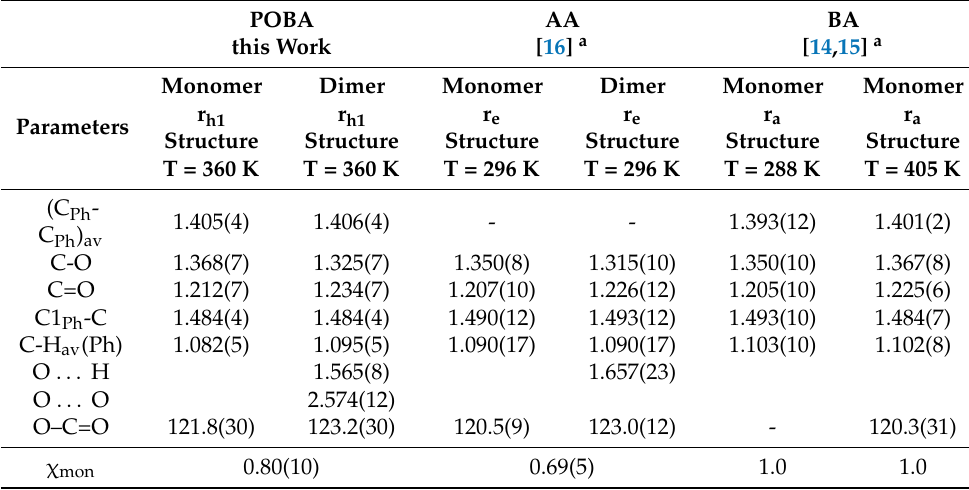
Table 3. The selected geometric parameters of AA, BA and POBA obtained by GED.